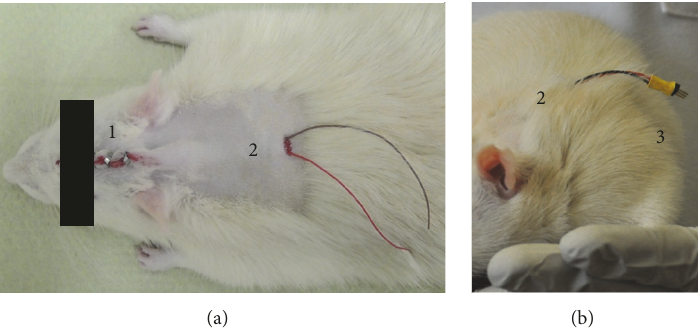
Figure 3: (a) Details of the outlet port for the subcutaneous cables centered at the dorsum. (b) Rat with electrode connector one week after surgery. 1: suture clips; 2: dorsal cable outlet port; 3: crimped plug connector. Table 1: Experimental design. The number of rats refers to the group sizes at the time of the apomorphine-induced rotation tests. Group